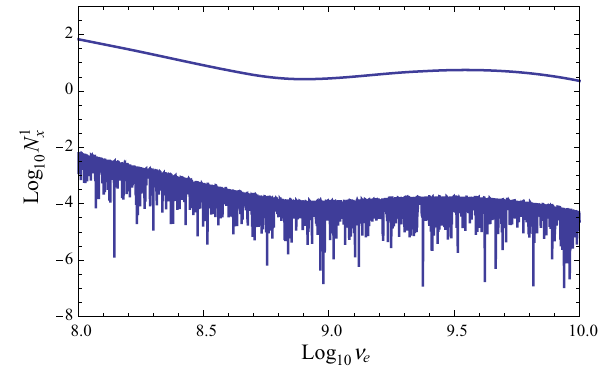
Fig. 4 The transverse PPF N 1 x | x = 0 . 035m generated by RGW and SGWB.ThelowercurveisthetransversePPFgeneratedbyRGWwhich ispredictedbythecanonicalsingle-fieldslow-rollinflationmodels.The upper curve is the transverse PPF generated by the SGWB correspond to the mergers of black hole binaries with chirp mass M c = 10 − 7 M (cid:2)